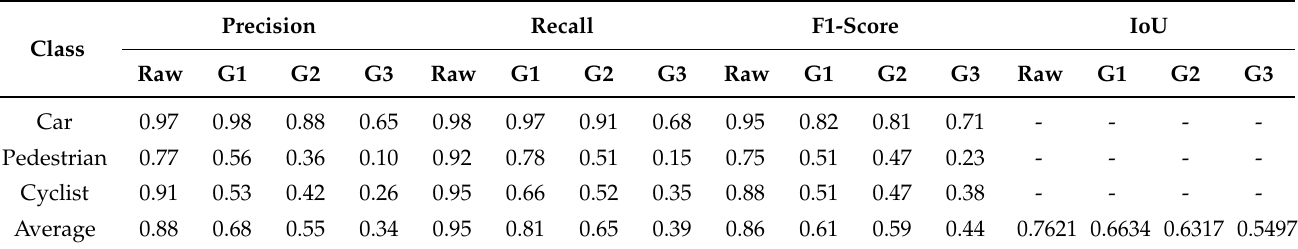
Table 3. Complex-YOLO architecture performance evaluated in raw and decompressed point clouds.